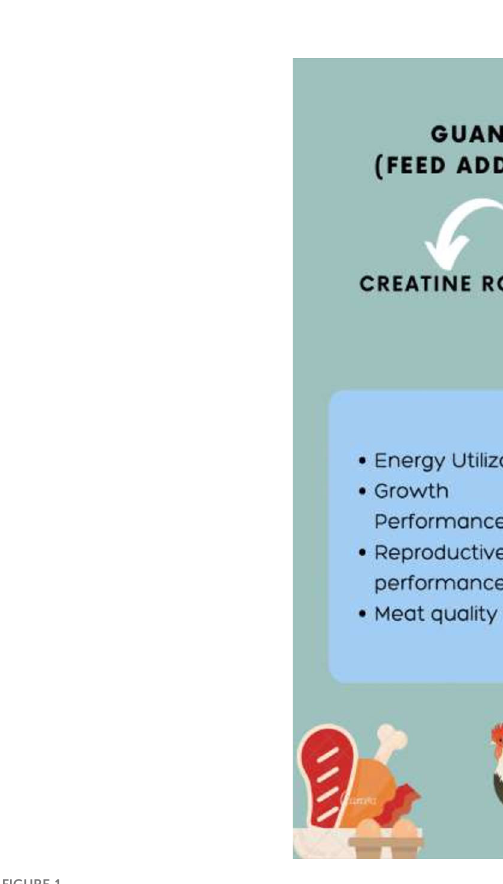
FIGURE 1 Graphical representation of effects of GAA in poultry and